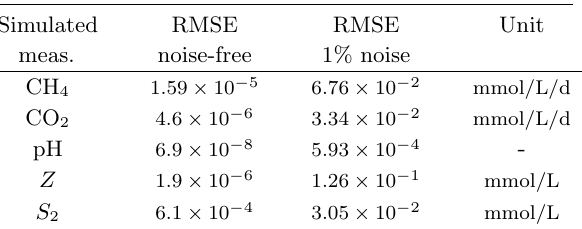
Table 4: Evaluation of the parameter identification based on RMSE Simulated RMSE RMSE Unit meas.